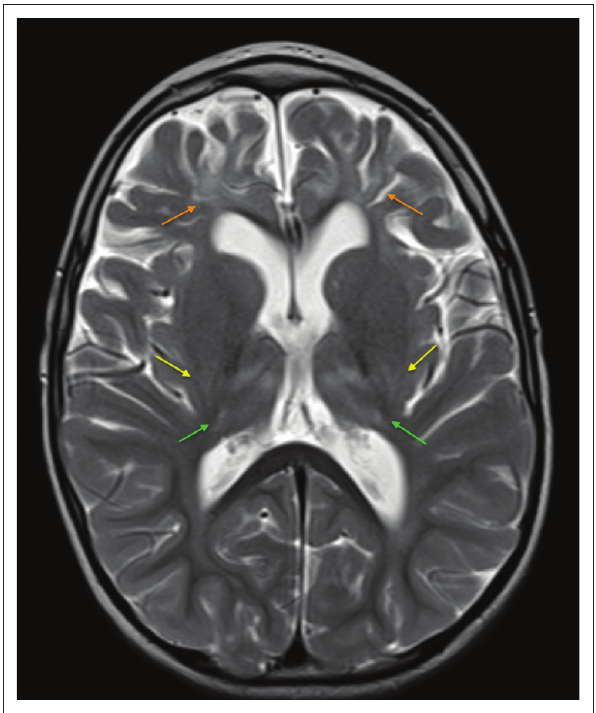
FIGURE 24: Axial T2-weighted image at the level of the basal nuclei performed on a 7-year-old male child. There is bifrontal encephalomalacia involving the middle and inferior frontal gyri (orange arrows) with ulegyria. Subtle hyperintensity is present at the posterior tips of the putamina (yellow arrows). Note in addition, loss of volume and more extensive hyperintensity of both thalami (green arrows). The combination is indicative of a mixed pattern of cerebral